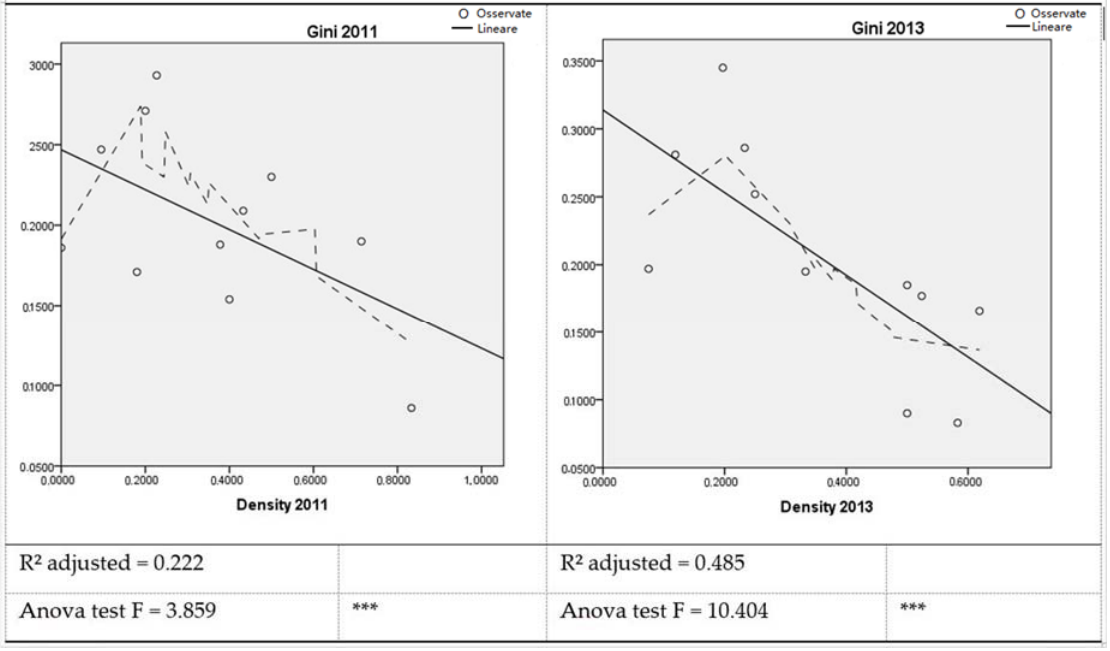
Figure 2. Estimated linear regression and Loess curve (50% points to adapt, kernel uniform) for 2011 and 2013.